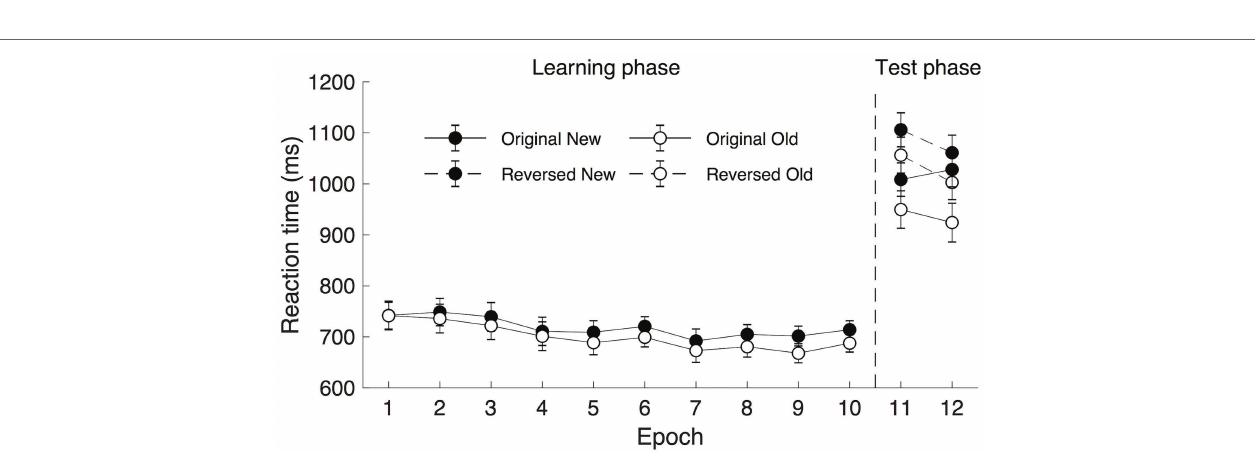
FIGURE 3 | Mean response time (RT) as a function of epoch and context for rapid display presentation (300 ms). The error bars represent the within-subject SE of the mean. The black circle lines indicate the new context and the open circle lines indicate the old context. The solid line indicates the original context and the dashed line represents the reversed